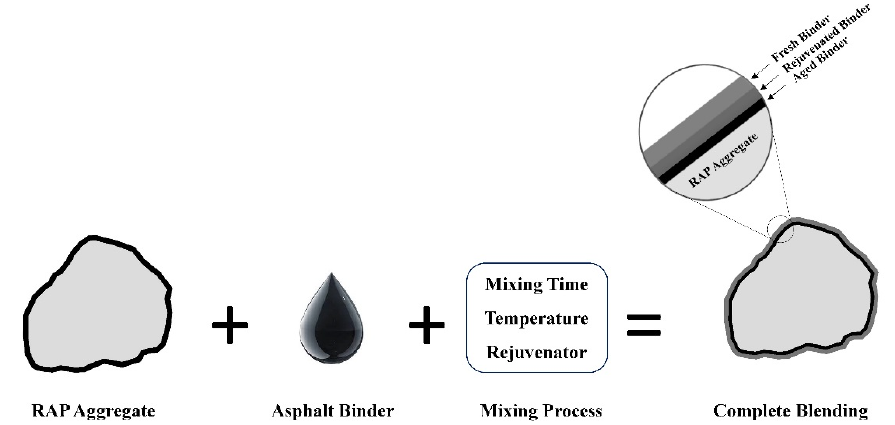
Figure 3. A complete blending of the virgin binder and RAP binder.